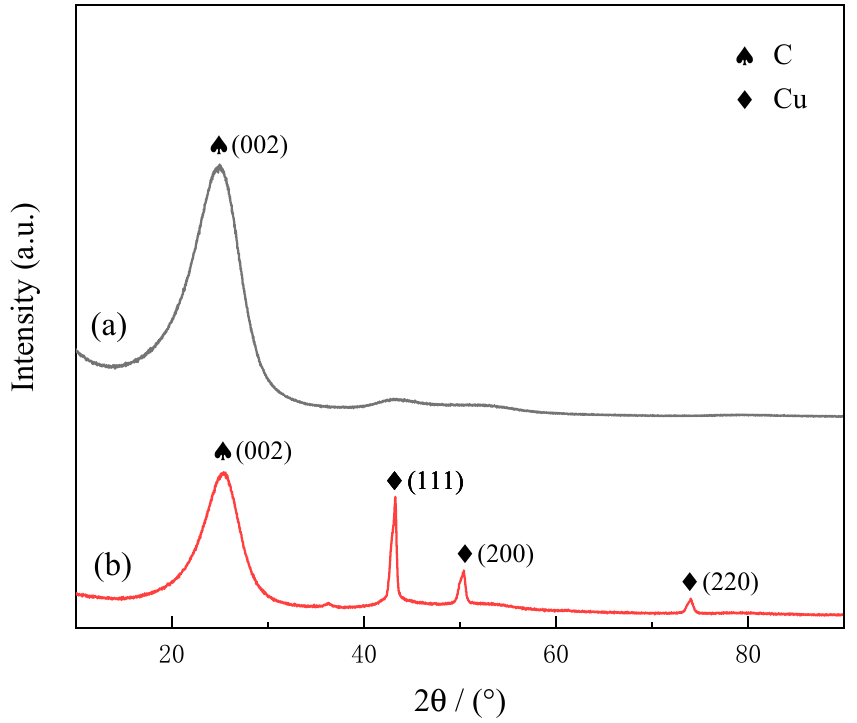
Figure 3. XRD spectra: ( a ) uncoated braided carbon fiber rope; ( b ) Cu-coated braided carbon fiber rope.